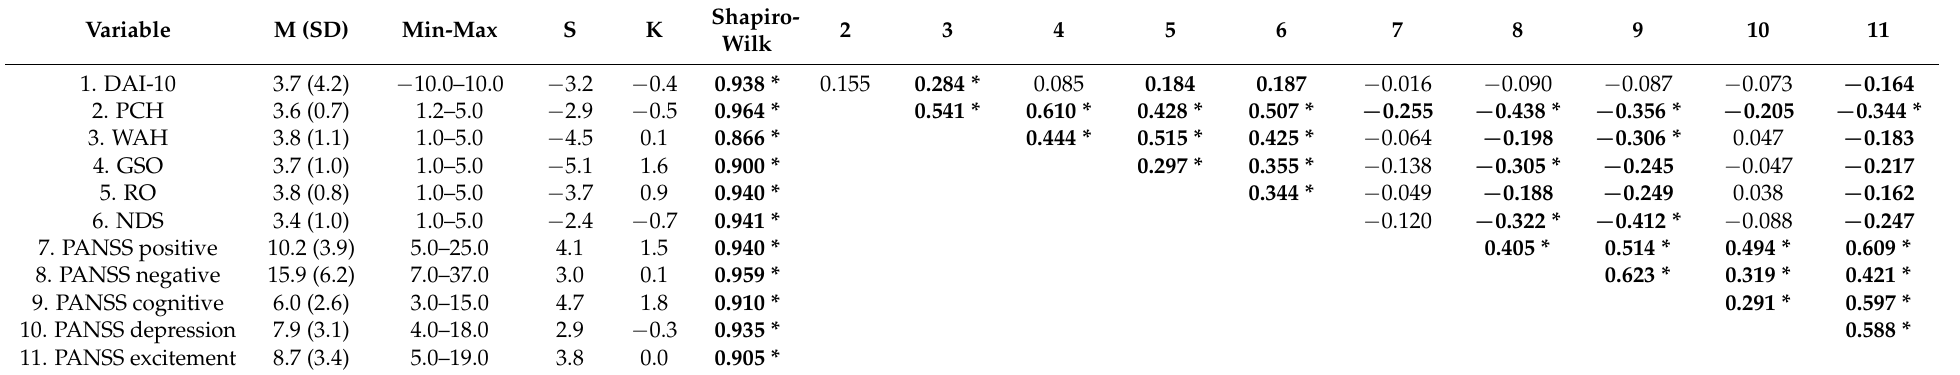
Table 2. Descriptive analysis of quantitative variables and correlation matrix between study